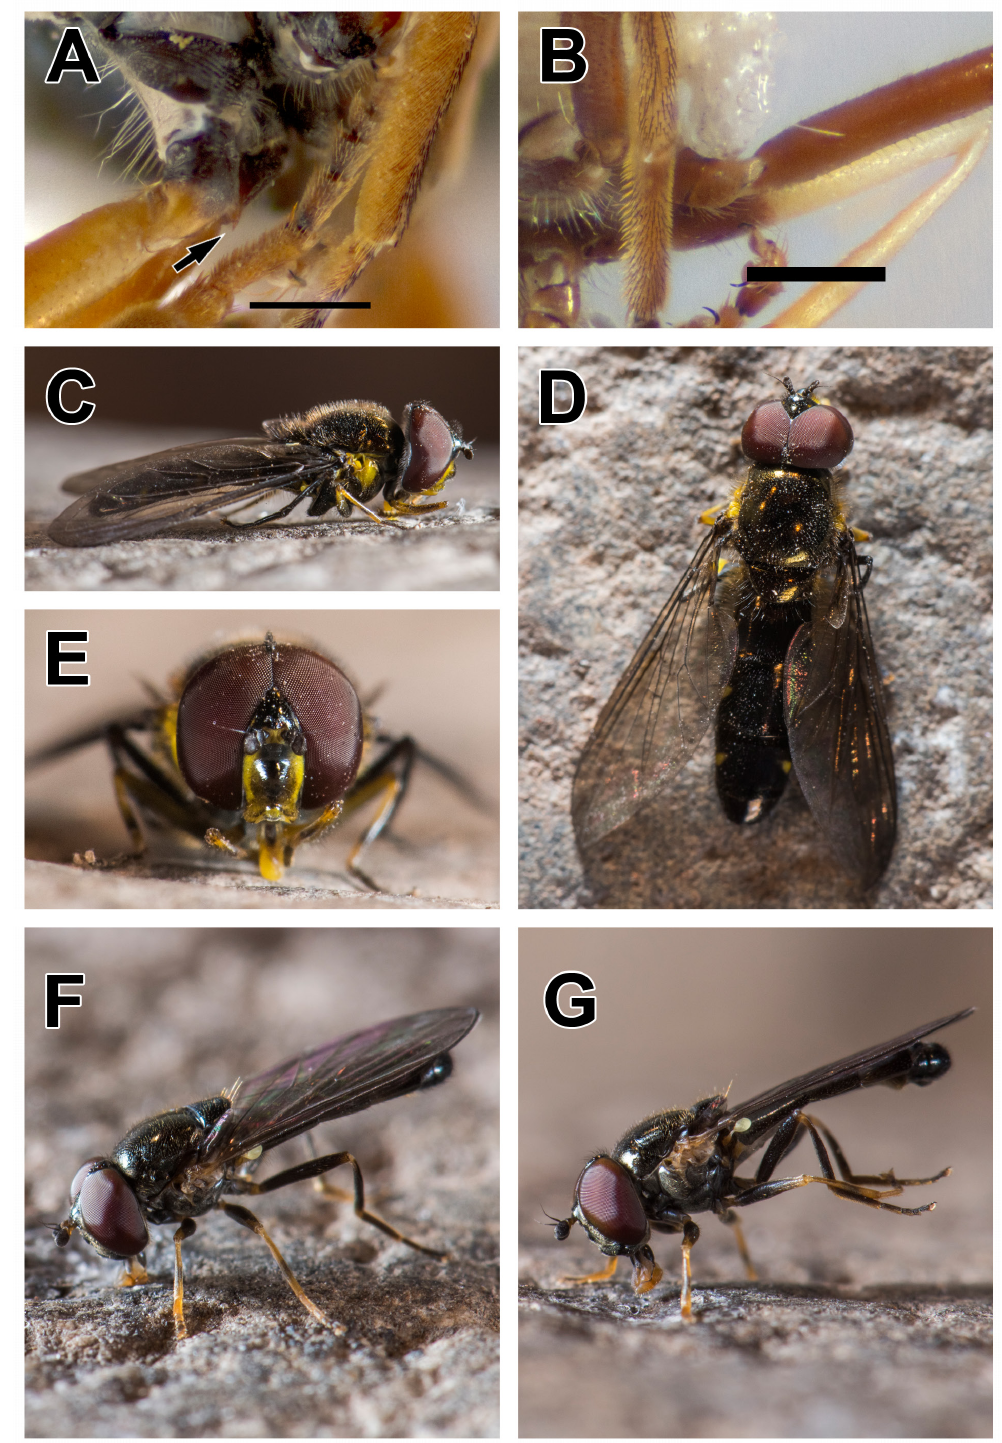
Fig. 6. A . Ischiodon scutellaris (Fabricius, 1805), ♂ (ZFMK-DIP-00019713), metacoxa and meta- trochanter. Arrow indicates the ventral spine-like process. B . Simosyrphus grandicornis (Macquart, 1842), ♂ (ZFMK-DIP-00019736), metacoxa and metatrochanter. C–E . Allograpta jacqui Mengual & Ramage sp. nov., holotype ♂ (ZFMK-DIP-00026906). C. Lateral view. D. Dorsal view. E. Frontal view. F–G . Melanostoma polynesiotes Mengual & Ramage sp. nov., paratype, ♂ (ZFMK-DIP-00026902). F. Dorsolateral view. G. Lateral view. Scale bars = 0.5